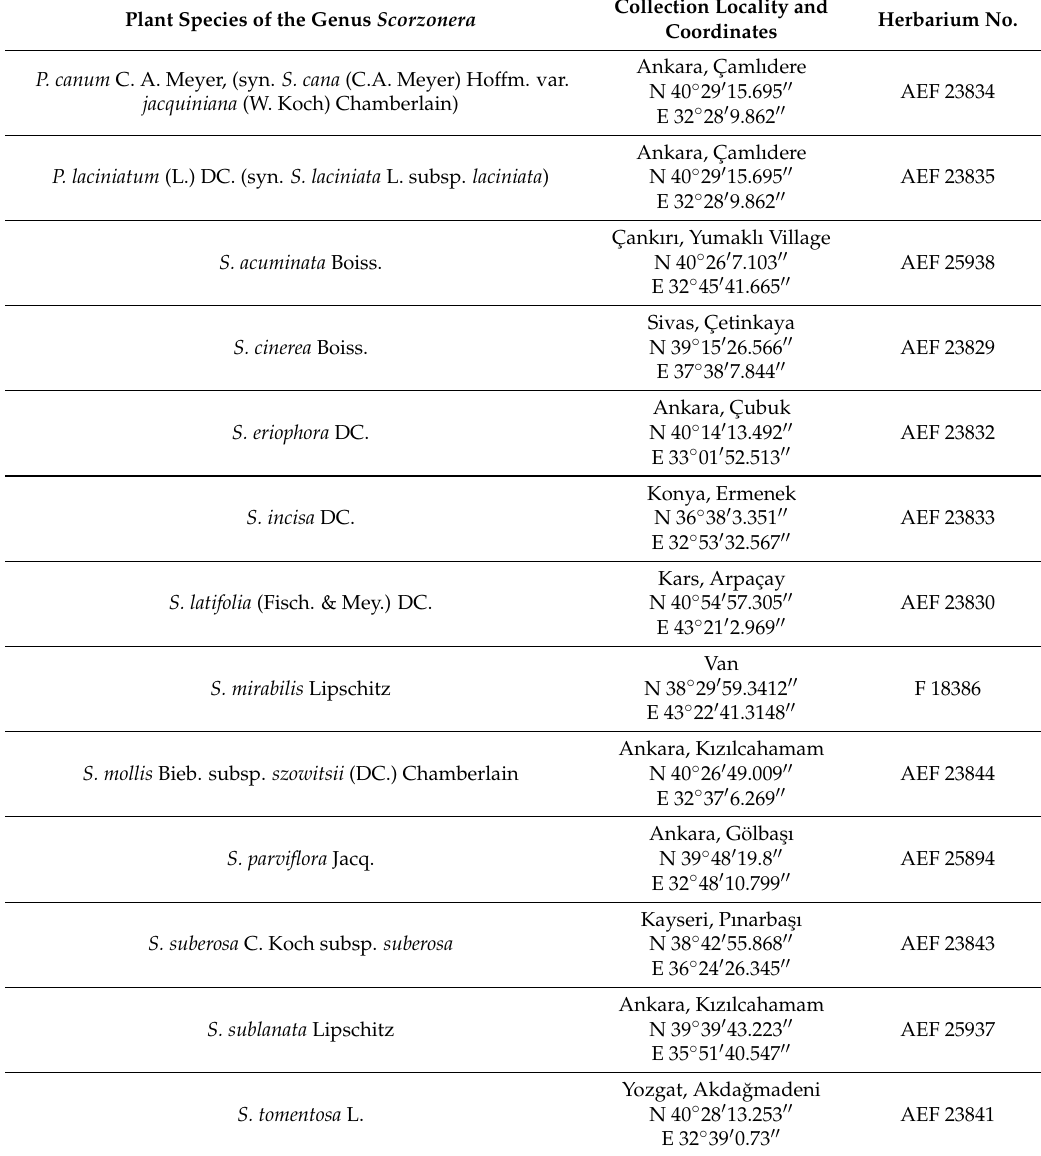
Table 3. Location of plant sample collection and the corresponding voucher specimen number. Plant Species of the Genus